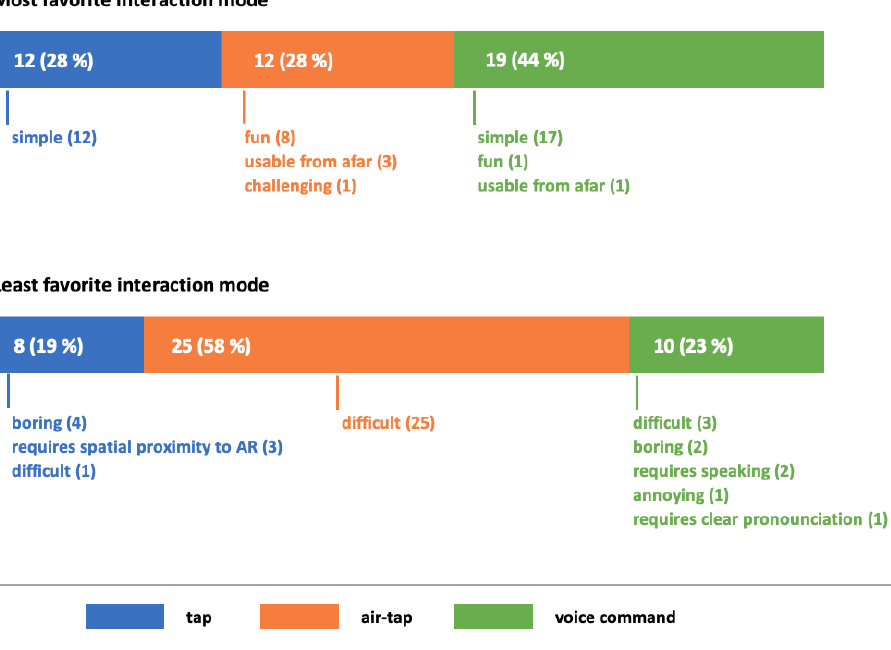
Figure 4. Distributions for most and least favorite interaction mode in AR with reasons for decisions (N = 43).